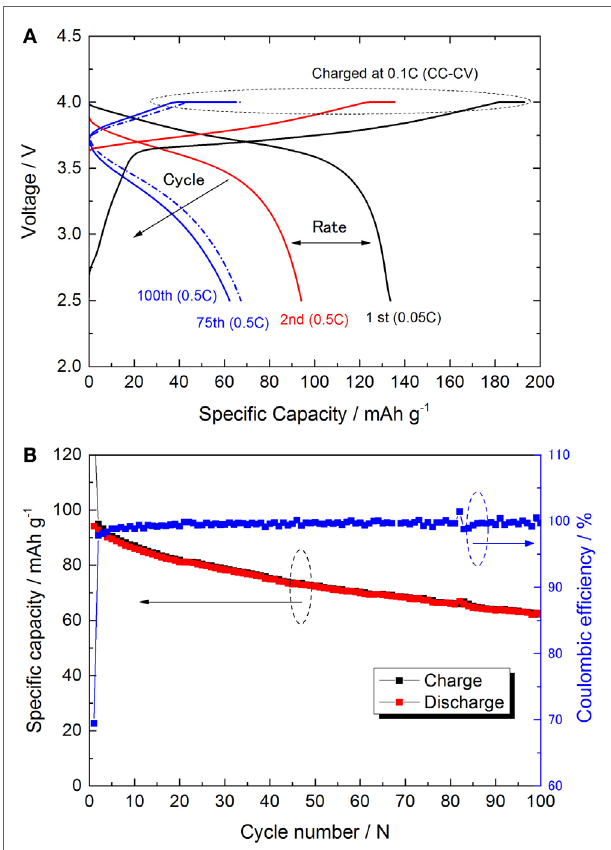
FigUre 5 | (a) Charge/discharge curves of NCA-cell for 1st, 10th, and 100th cycle at 25°C. The 0.1 C constant current–4.0 V constant voltage (CC–CV) mode was adopted for all the charge sequences. First discharge was done at 0.05 C to check the full capacity. (B) Charge/discharge capacities and the coulombic efficiency are plotted versus the cycle (within the 2nd cycle to 100th cycle).